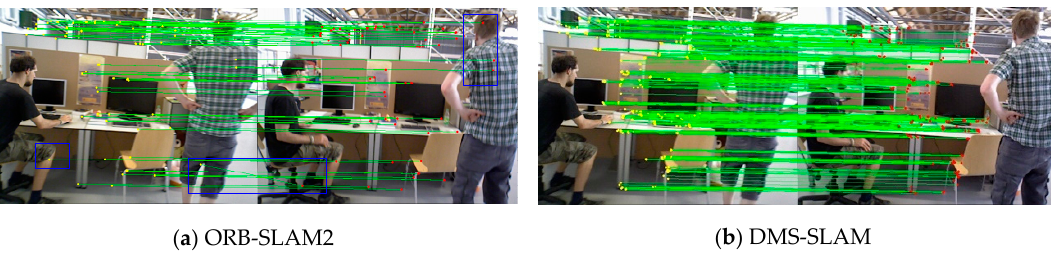
Figure 8. ( a , b ) Feature matching results between keyframes in ORB-SLAM2 and DMS-SLAM. The blue boxes in the figure indicate the dynamic area or the wrong feature matching point pairs.